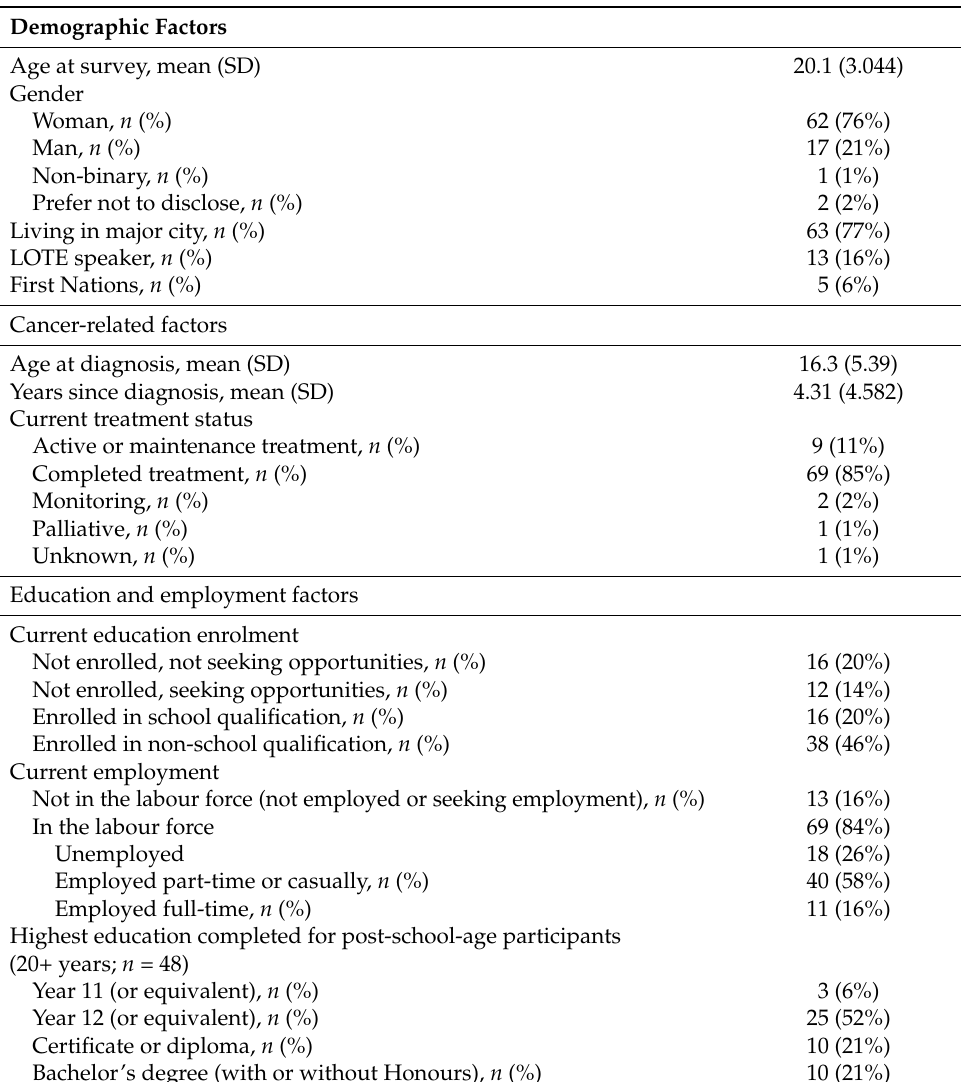
Table 1. Descriptive characteristics of the participants ( n =